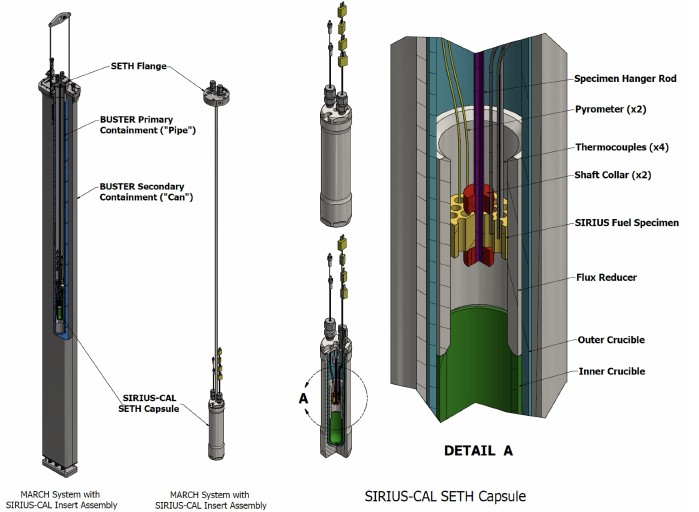
Figure 4. Illustration of SIRIUS-CAL within the MARCH